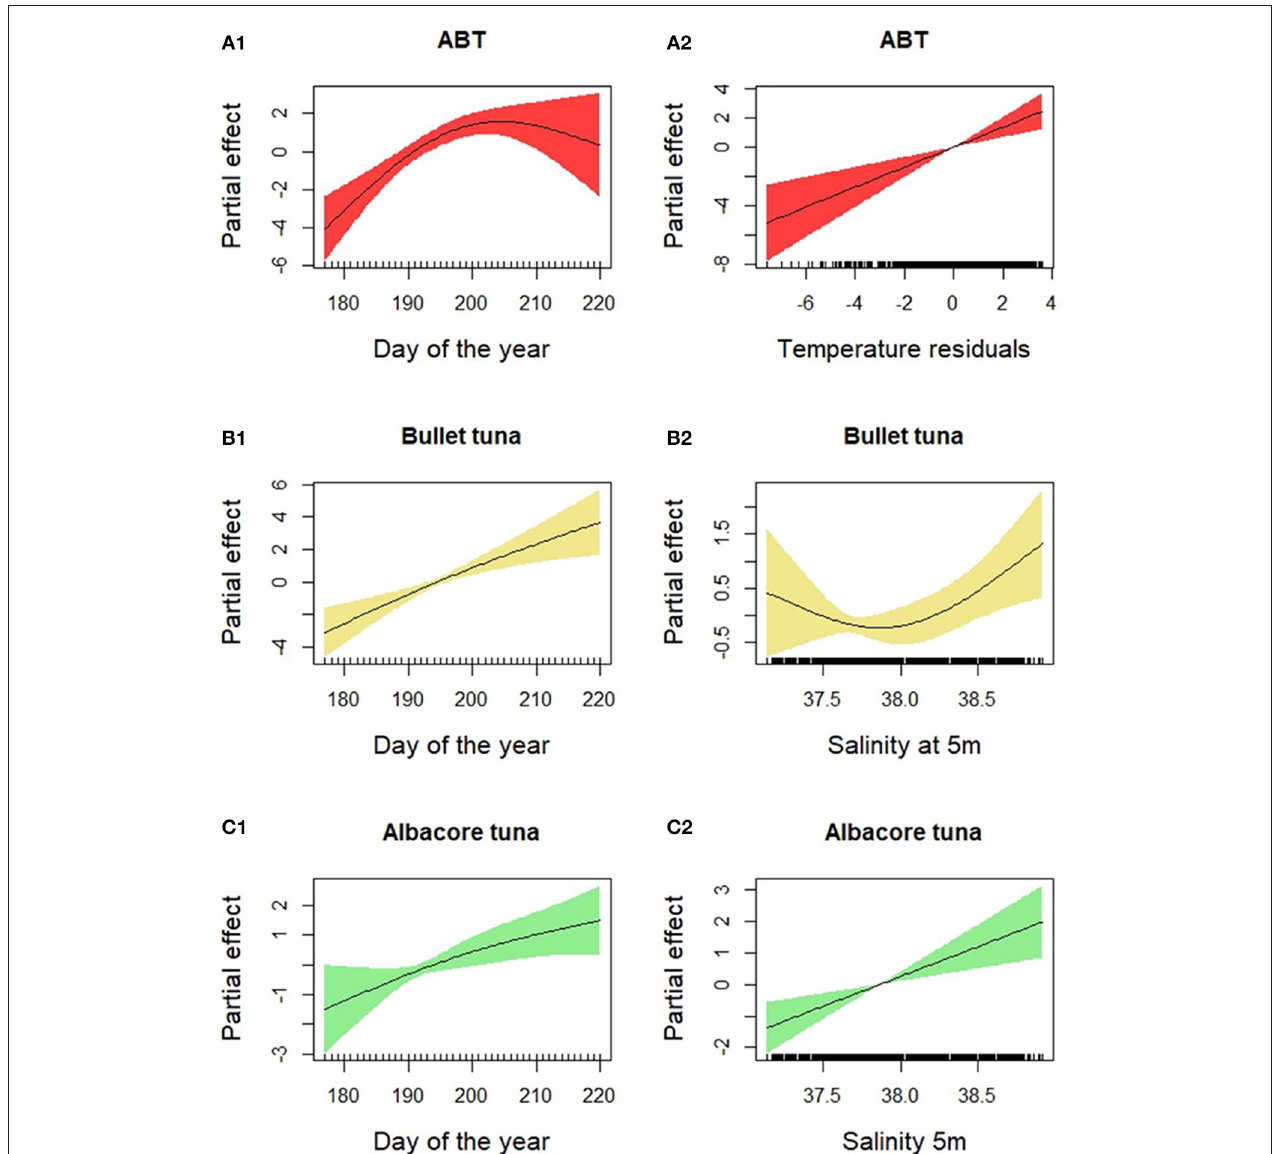
FIGURE 5 | Results of the generalized additive presence-absence models for (A1,A2) bluefin tuna, (B1,B2) bullet tuna, and (C1,C2) albacore